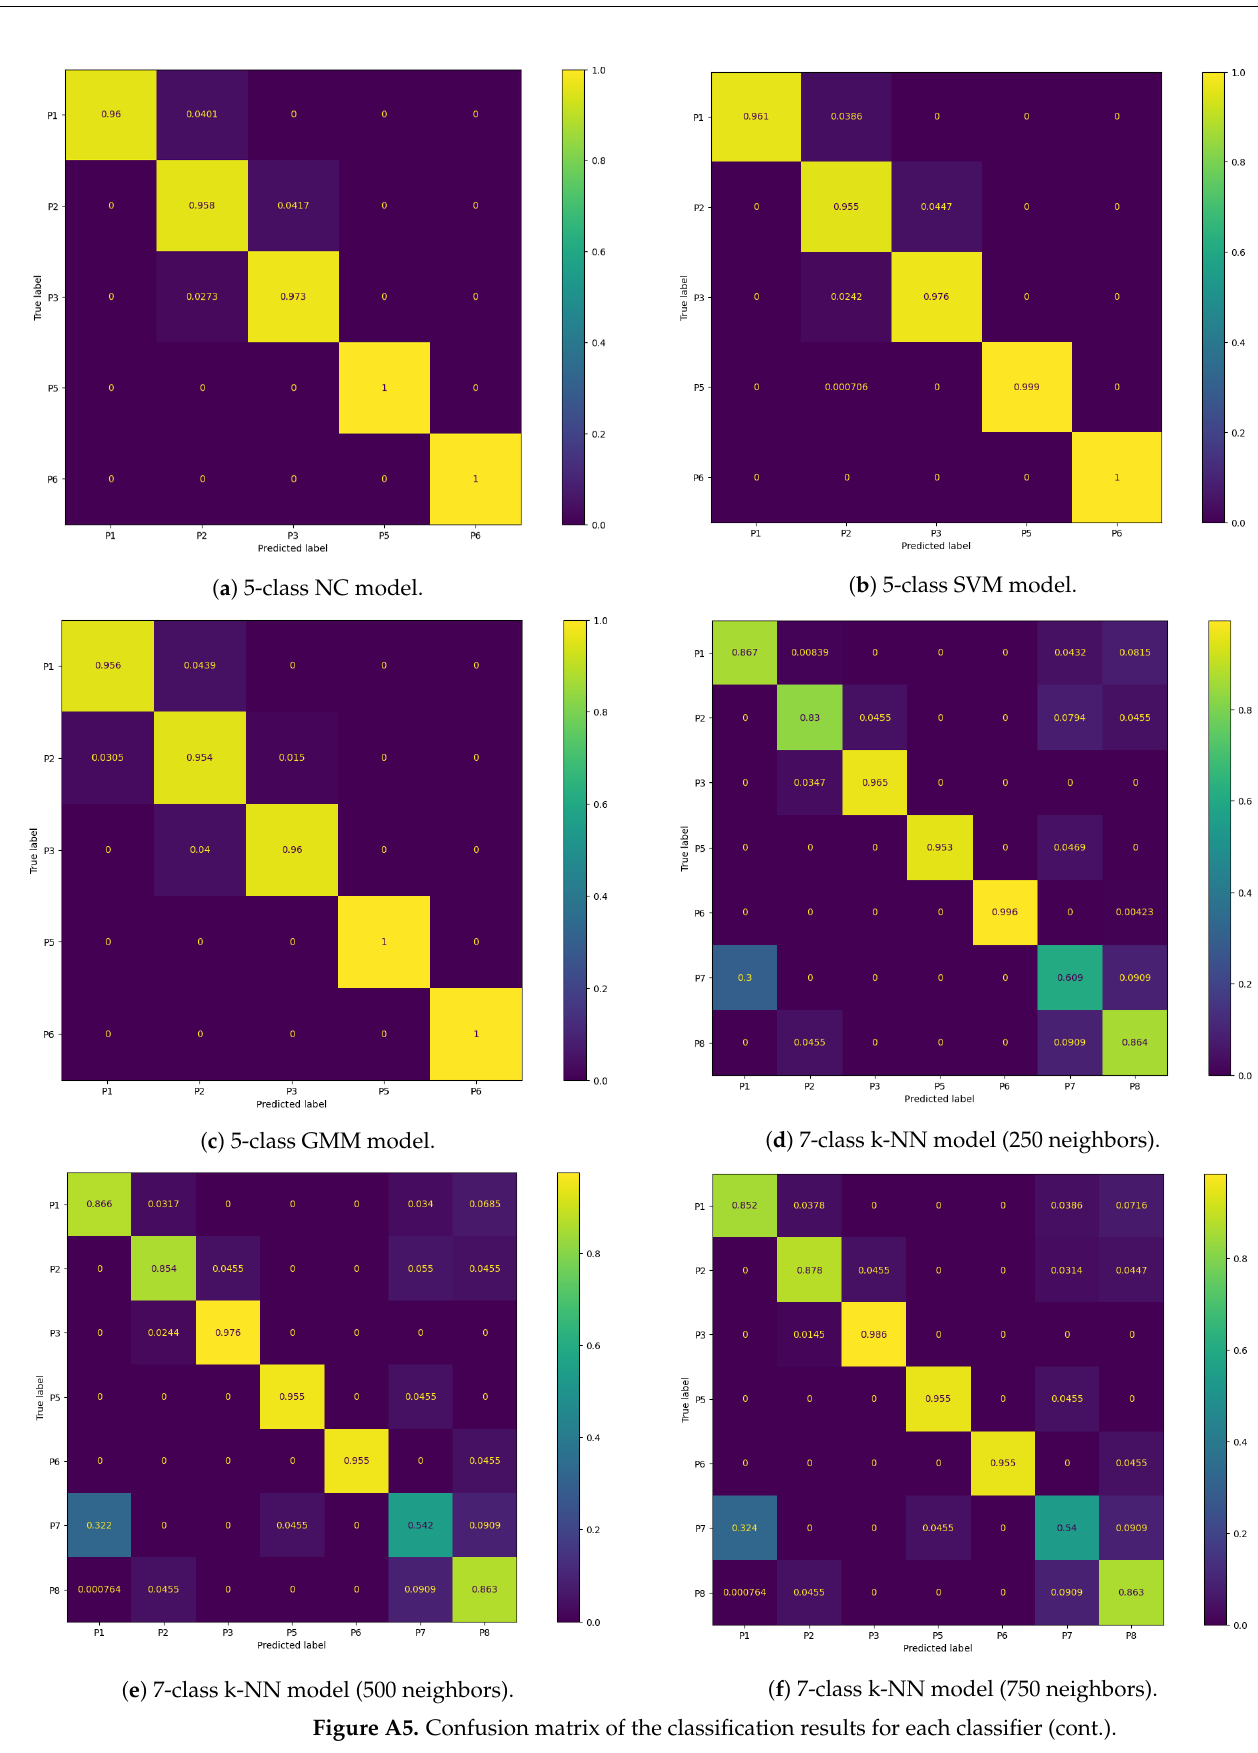
Figure A5. Confusion matrix of the classification results for each classifier